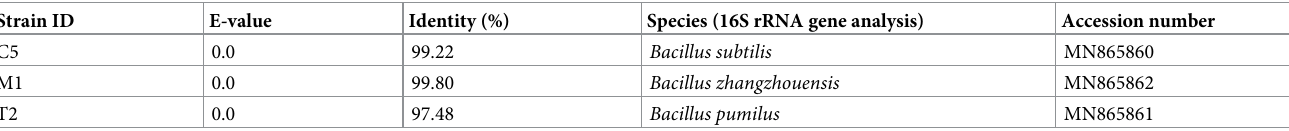
Table 1. Partial 16S rRNA sequencing of Bacillus strains and strain